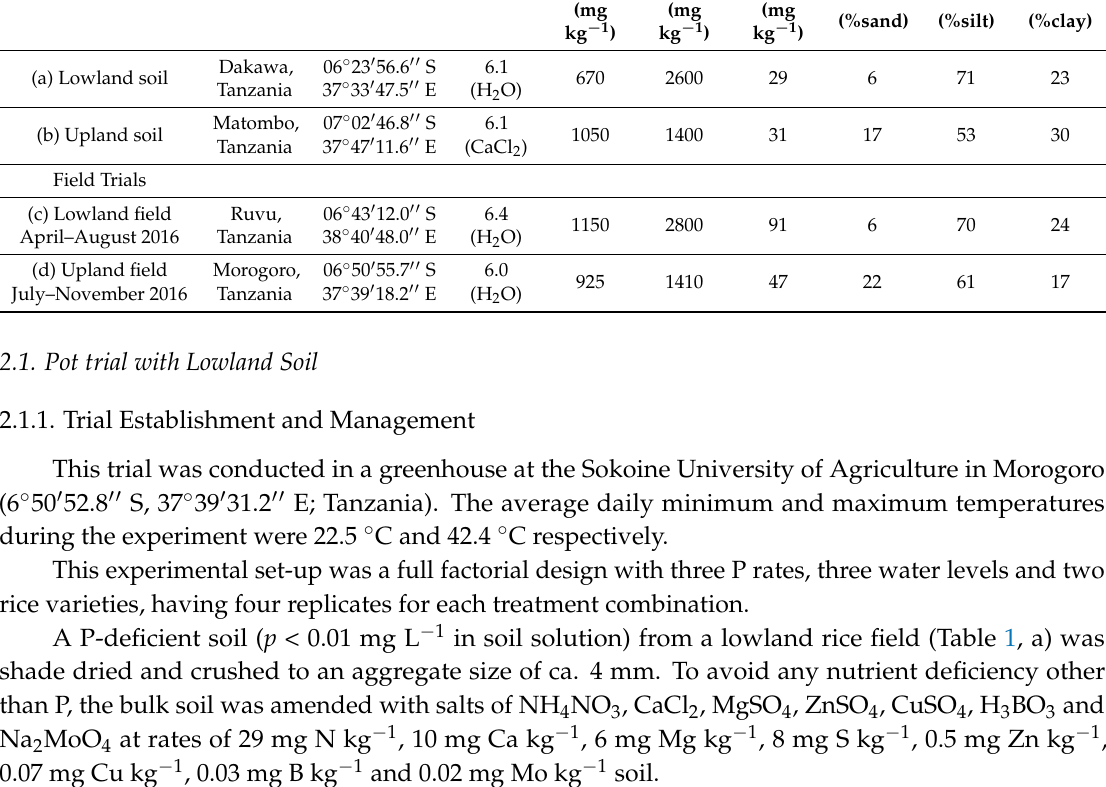
Table 1. Soil characteristics from pot and field experiments. Soils were sampled up to a depth of 30 cm. Pot Trials Location